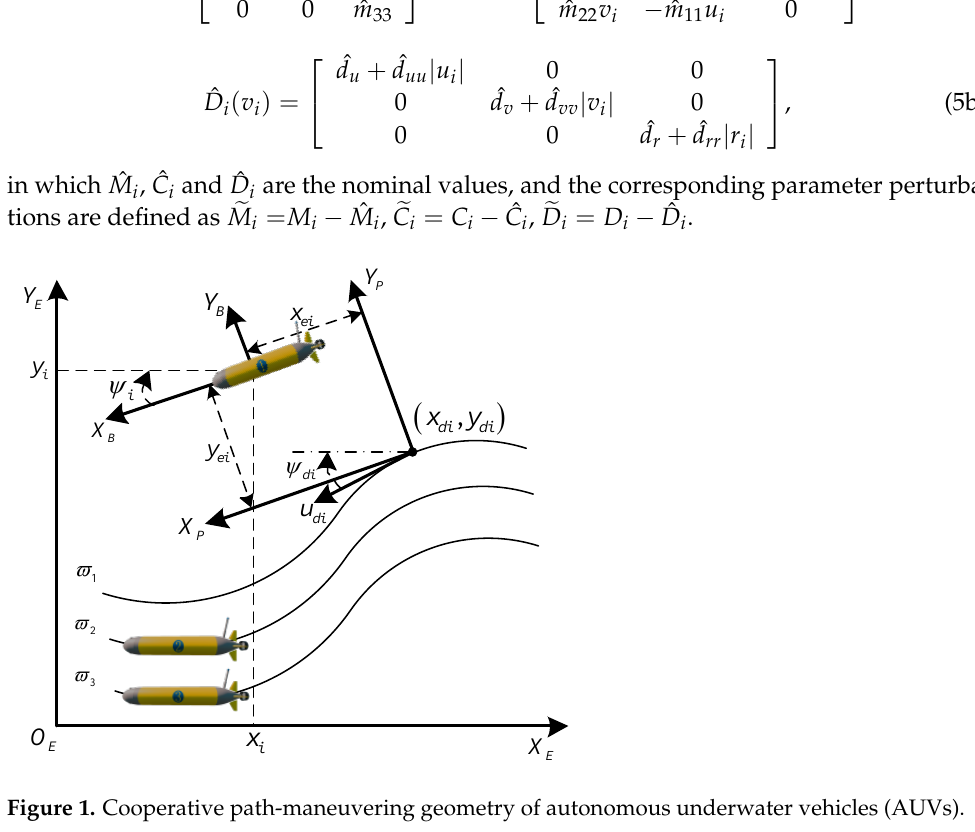
Figure 1. Cooperative path-maneuvering geometry of autonomous underwater vehicles